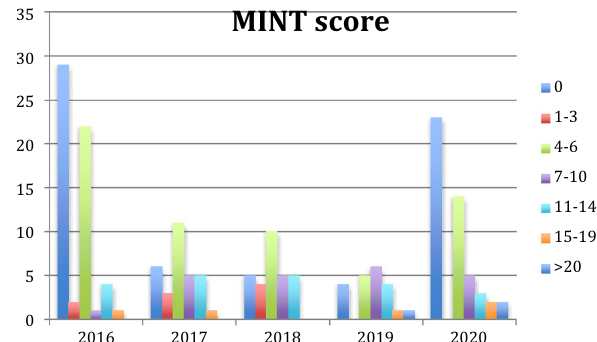
Figure 2. Overview of MINT score during the study period. During the study period the percentage of newborns with null MINT decreased from 44 to 36%; the proportion of infants with MINT between 4 and 6 decreased from 33 to 22%; the percentage of infants with MINT between 7 and 10 increased from 1.5% to 7.8%; infants with MINT greater than 15 increased from 1.5 to 6.2%.